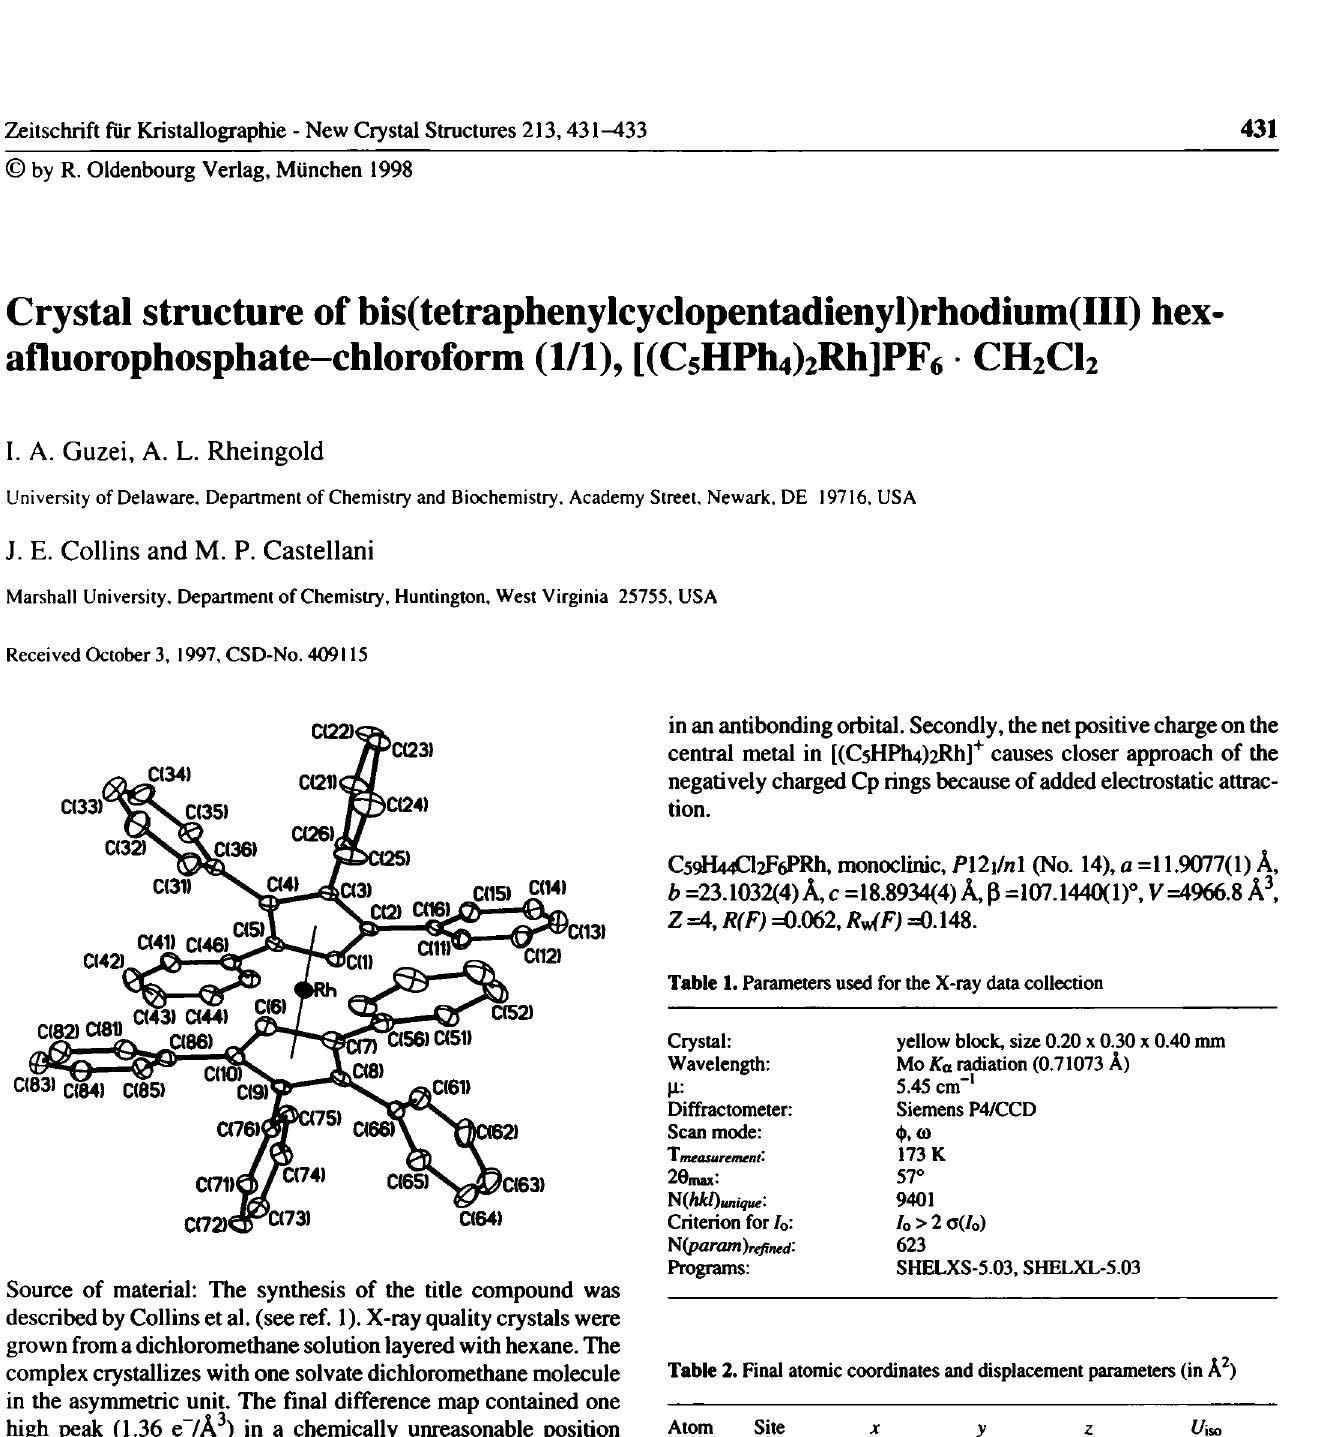
Table 2. Final atomic coordinates and displacement parameters (in